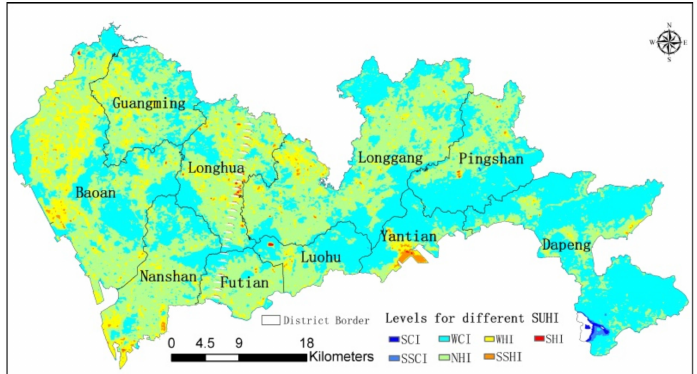
Figure 6. SUHI grades on 7 October